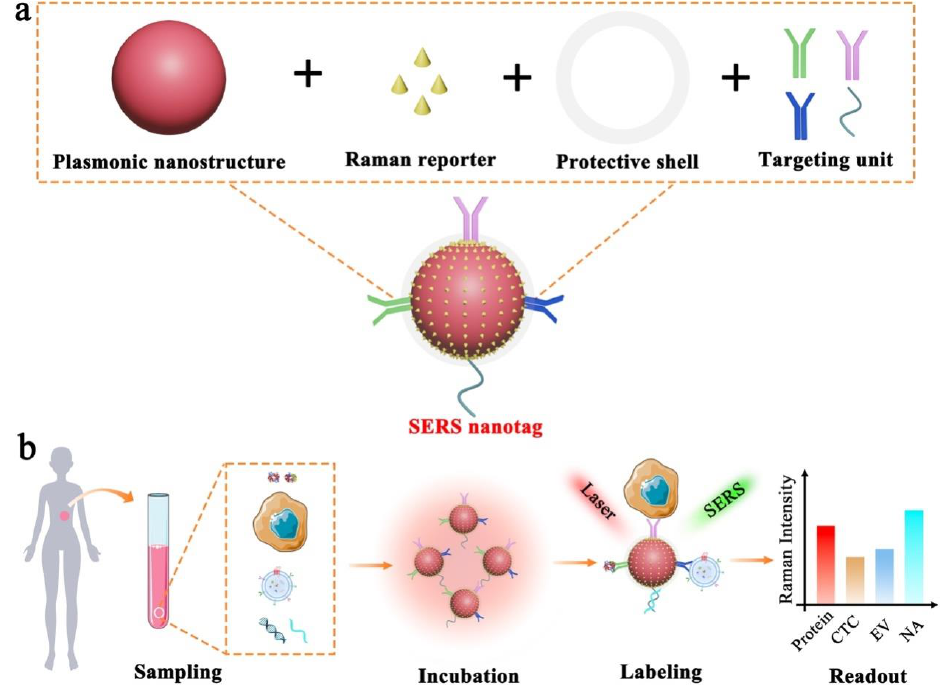
Figure 1. Schematic illustration of SERS nanotag enabled highly sensitive and multiplexed detec- tion of cancer circulating biomarkers. ( a ) The design of a typical SERS nanotag with the use of four key components. ( b ) The application of SERS nanotags in the detection of protein, CTC, EV, and NA.